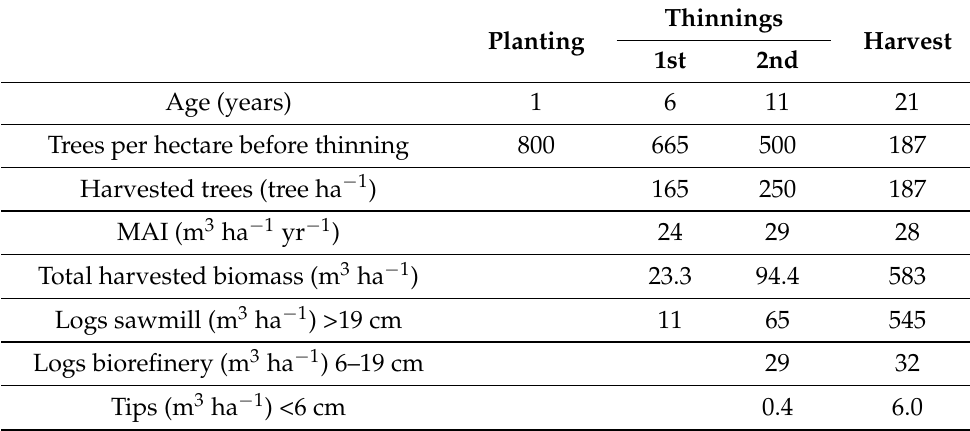
Table 4. Solid wood production with Eucalyptus plantations.